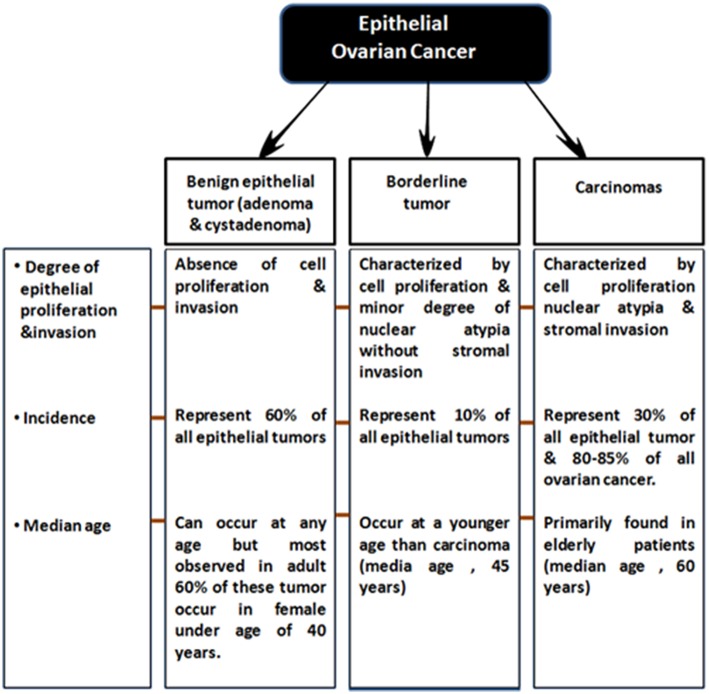
Sub-classification of epithelial ovarian tumors.